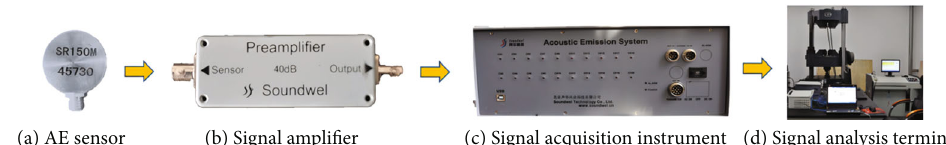
Figure 3: Acoustic emission signal transmission process.